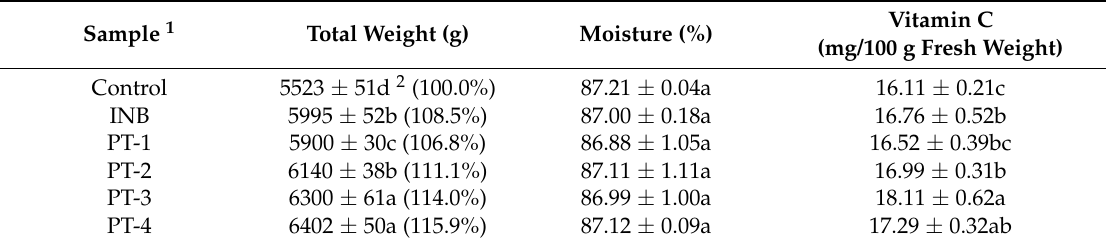
Table 1. Effect of Indolbi (INB) and persimmon fruit powder on yield and moisture and vitamin C contents of soybean sprouts cultivated for 6 days.